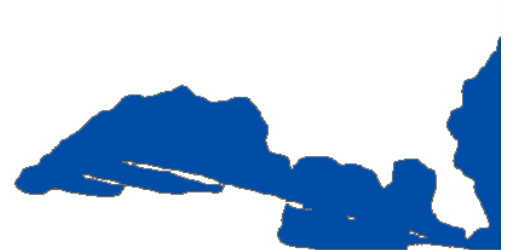
Figure 9. Selected ocean regions Then, the alpha-shapes algorithm is applied to create the boundary of the points, which is the coastline. This is only applied to where LIDAR dataset is available.